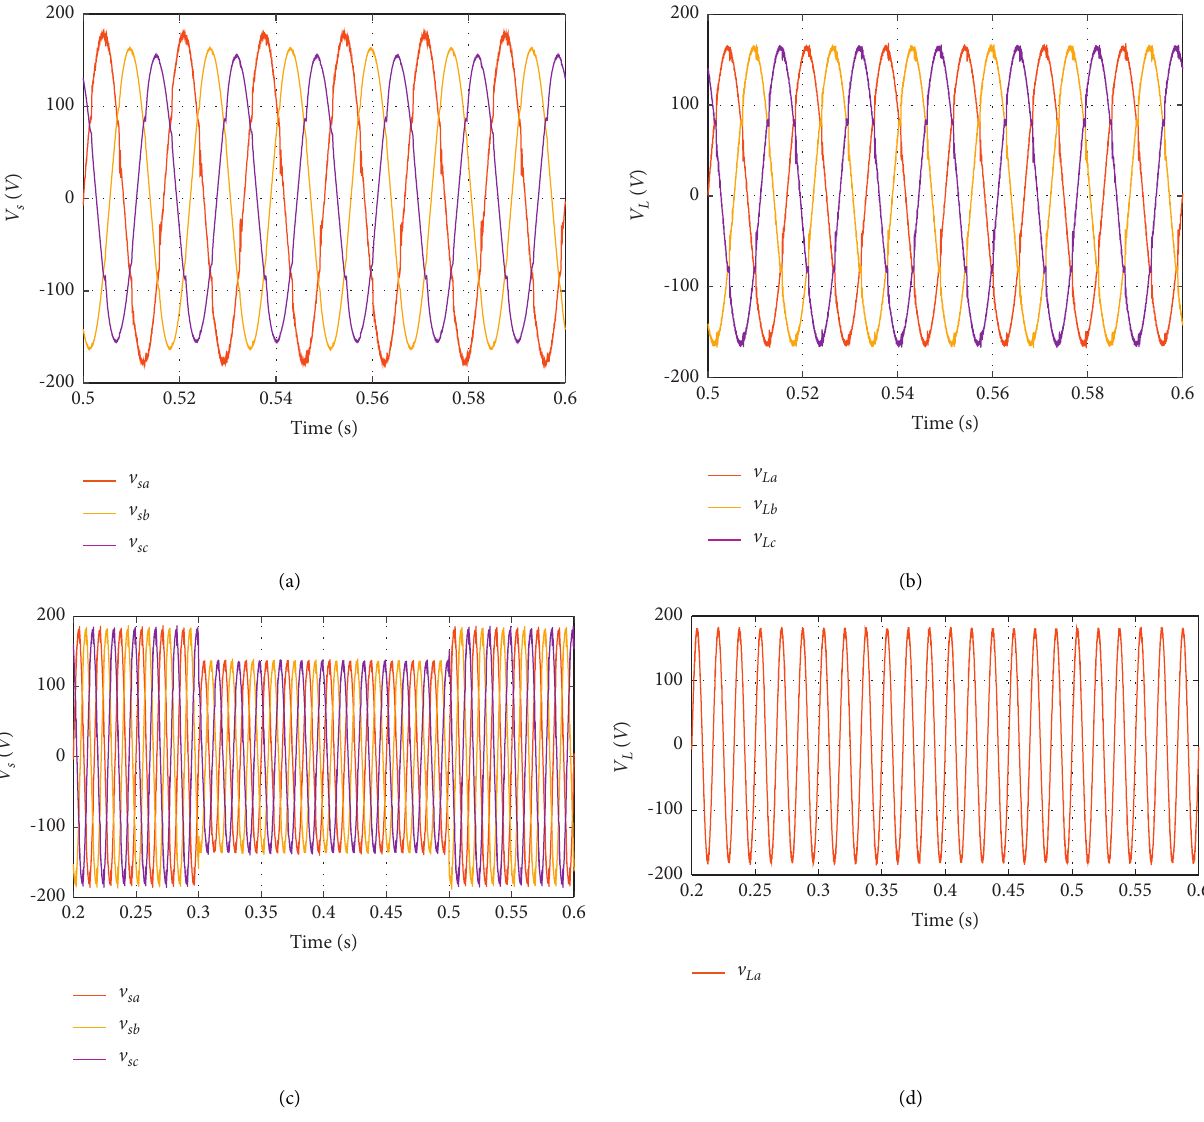
Figure 7: Wind-PV-UPQC coupled to asymmetrical and distorted utility grid P